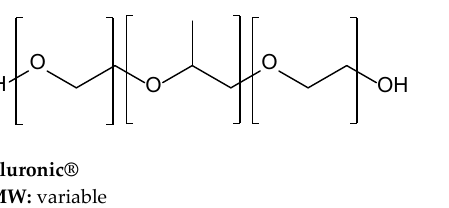
Figure 4. Chemical structures and molecular weights (MW) of various synthetic polymers used to manufacture cross-linked gels.